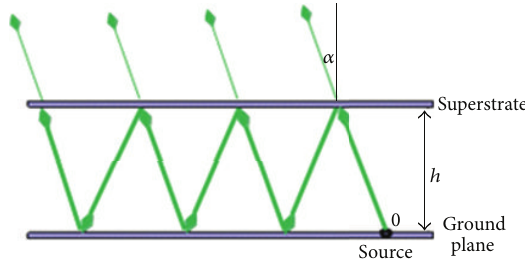
Figure 1: F-P resonant cavity composed of a ground plane and a superstrate.